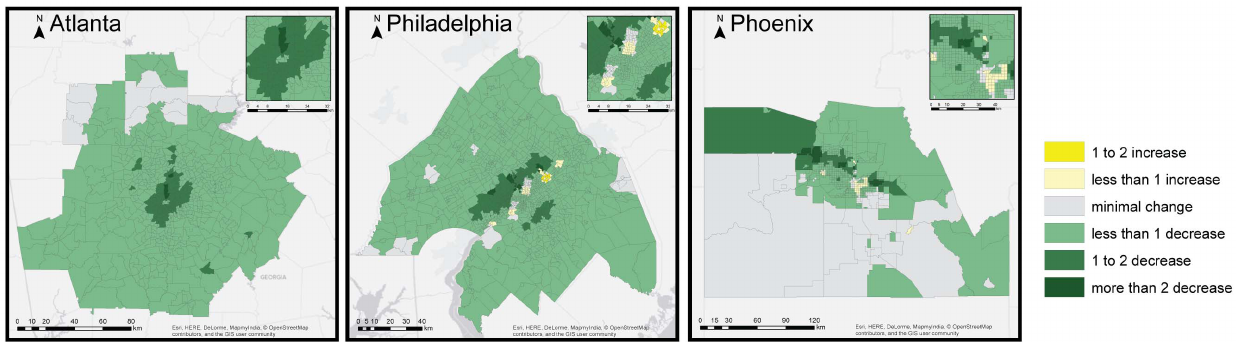
Figure 5. Change in mortality (per 100,000 population) under the ALL scenario in Atlanta, Philadelphia, and Phoenix. 2050 mortality changes are estimated in response to the Medina-Ramon/Anderson HRFs and are based on the difference in mortality between the BAU and ALL scenarios.